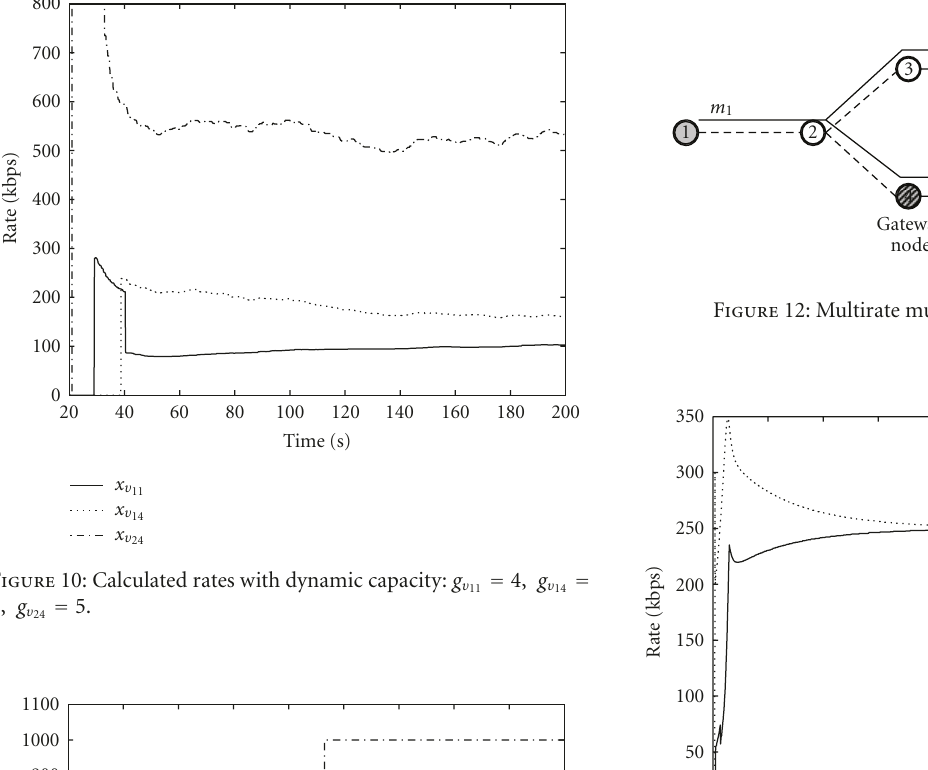
Figure 10: Calculated rates with dynamic capacity: g υ = 5. 1, g υ 24